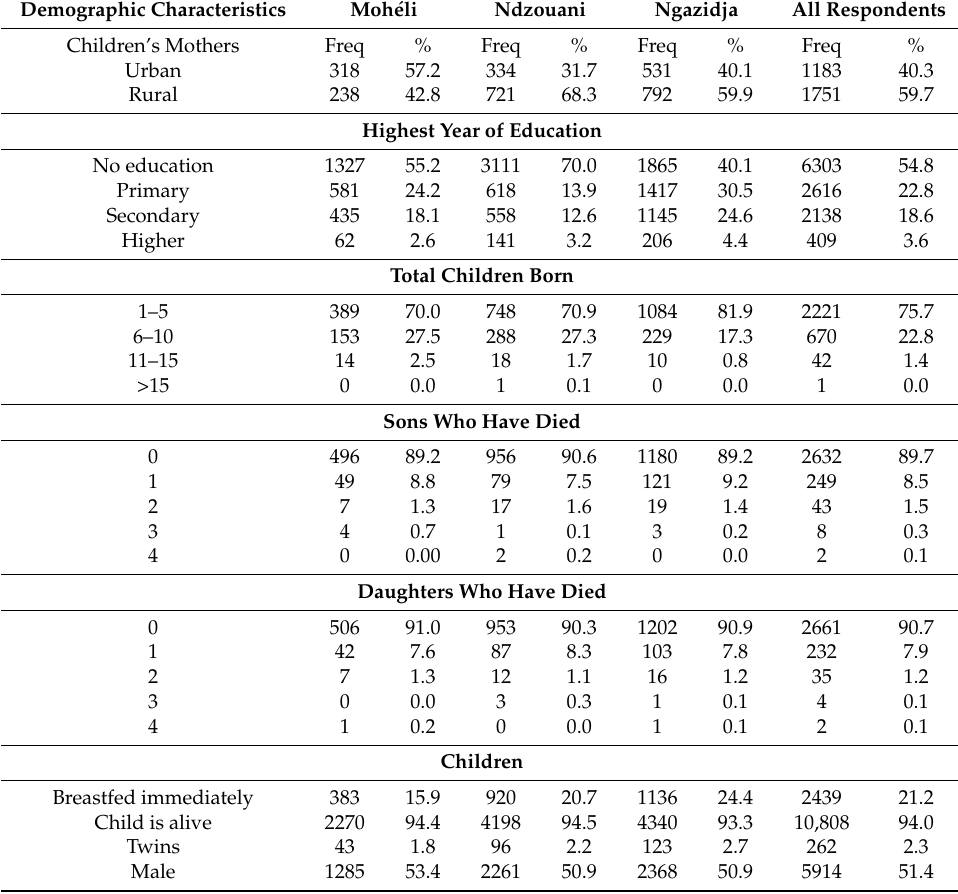
Table 2. Descriptive statistics of selected characteristics of children in the Comoros’